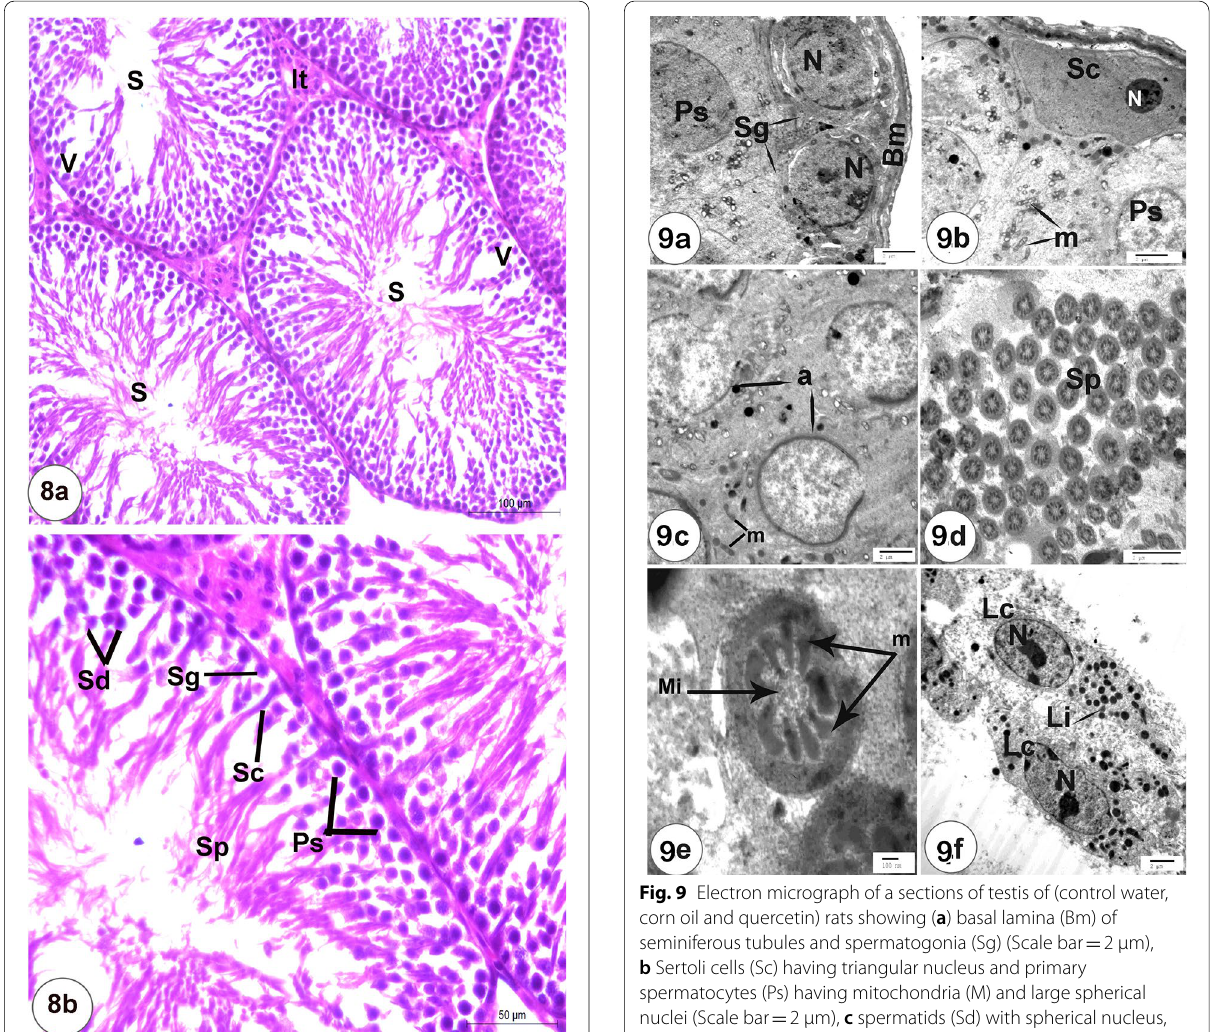
Fig. 8 Photomicrographs of a section of testis of MSG group treated with quercetin showing ( a ) Seminiferous tubules (S) and interstitial containing Leydig cells (It) and cytoplasmic vacuolation (v) (Scale bar 100 µm). b Higher magnification of same section = showing spermatogonia (Sg) resting upon the basal lamina of the seminiferous tubules that are oval in shape, primary spermatocytes (Ps), recognized by their large nuclei containing coarse clumps of chromatin, spermatids (Sd) with rounded nuclei, Sertoli cells (Sc) with nuclei located basally, and sperms in the lumen of the tubules (Sp) (Scale bar 50 µm) =